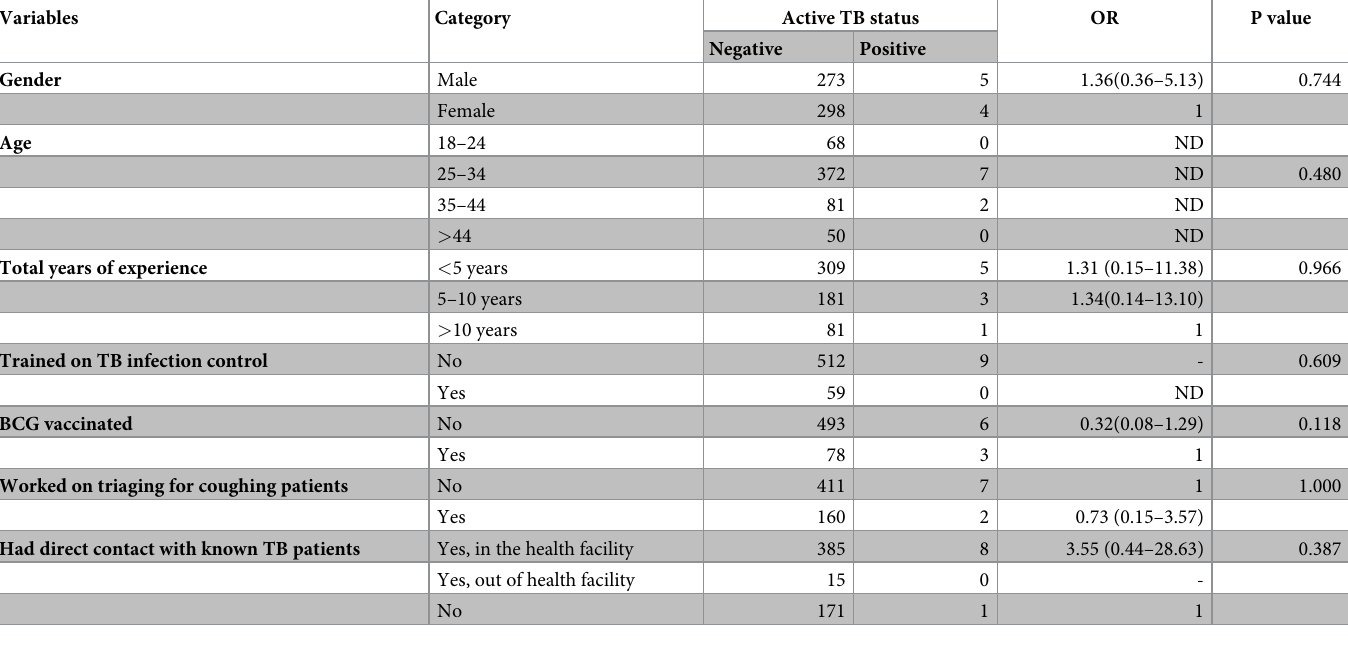
Table 4. TB detected cases and associated factors in Amhara